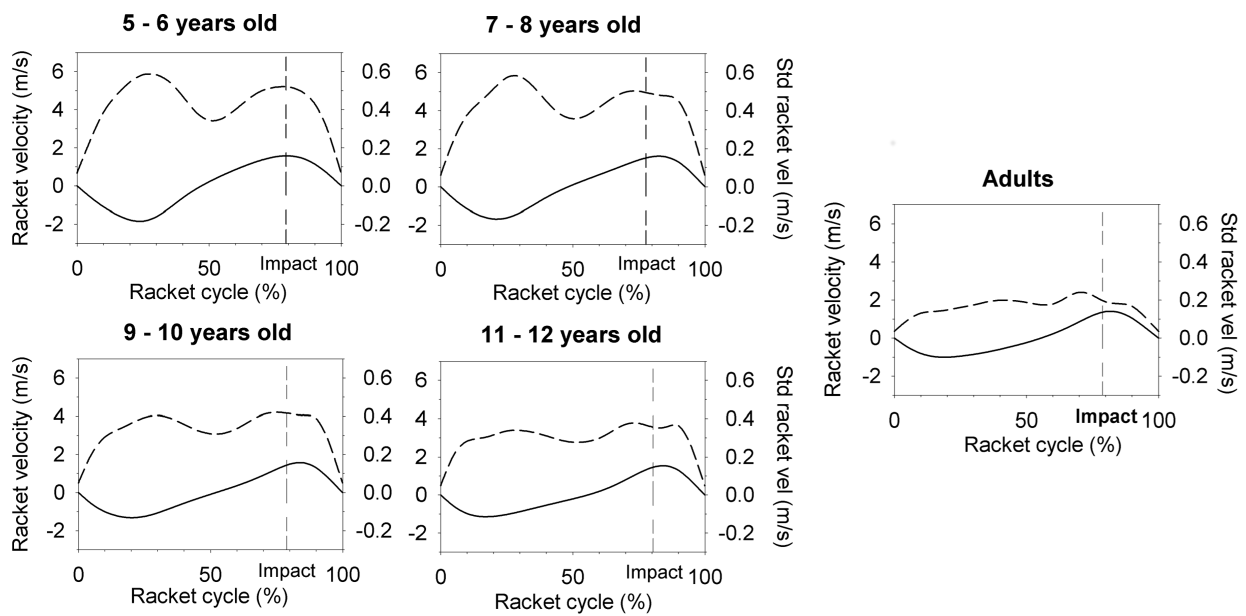
Figure 5. Racket velocity profiles. Mean racket velocity (solid line) and mean within-trial standard deviation (dash line) for the last trial of each age group.